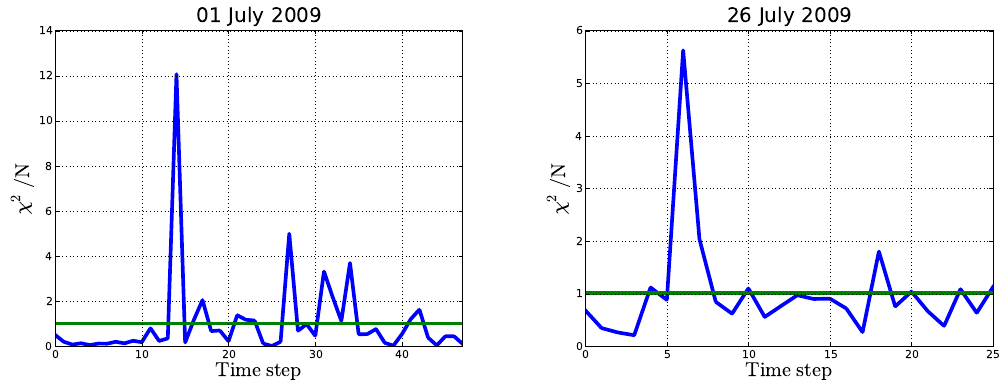
Fig. 10. Time evolution of χ 2 /N (blue lines) for DA runs on 1 and 26 July 2009. The mean over DA window of χ 2 /N is 1.02 (1.02) for 1 (26) July